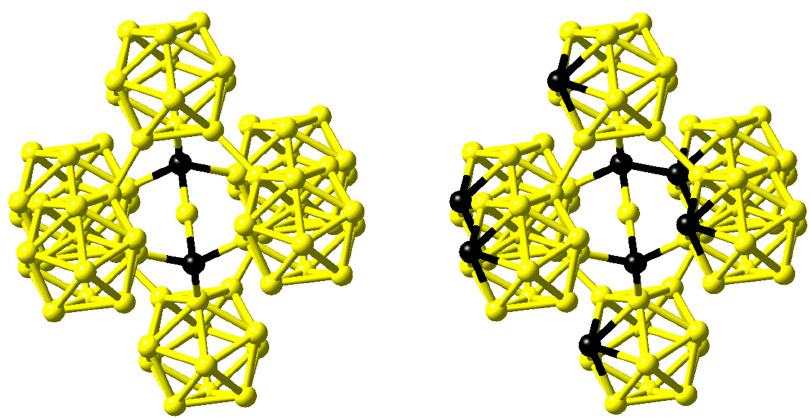
Figure 10. Structure of B 13 C 2 as proposed by Larson [33] ( left ) and structure of B 4 C as proposed by Lazzari et al. [35] ( right ). Boron and carbon atoms are shown in yellow and black, respectively.